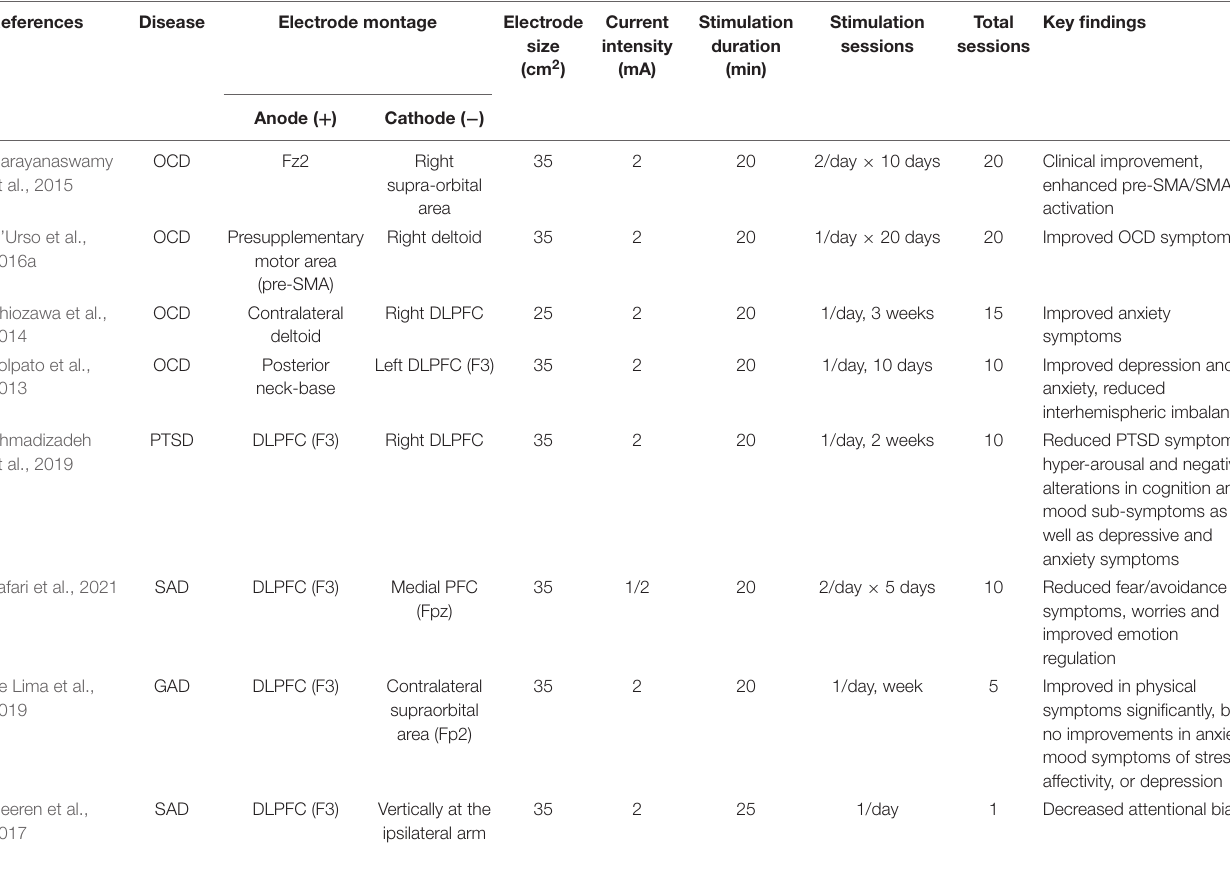
TABLE 5 | Effects of tDCS on OCD and